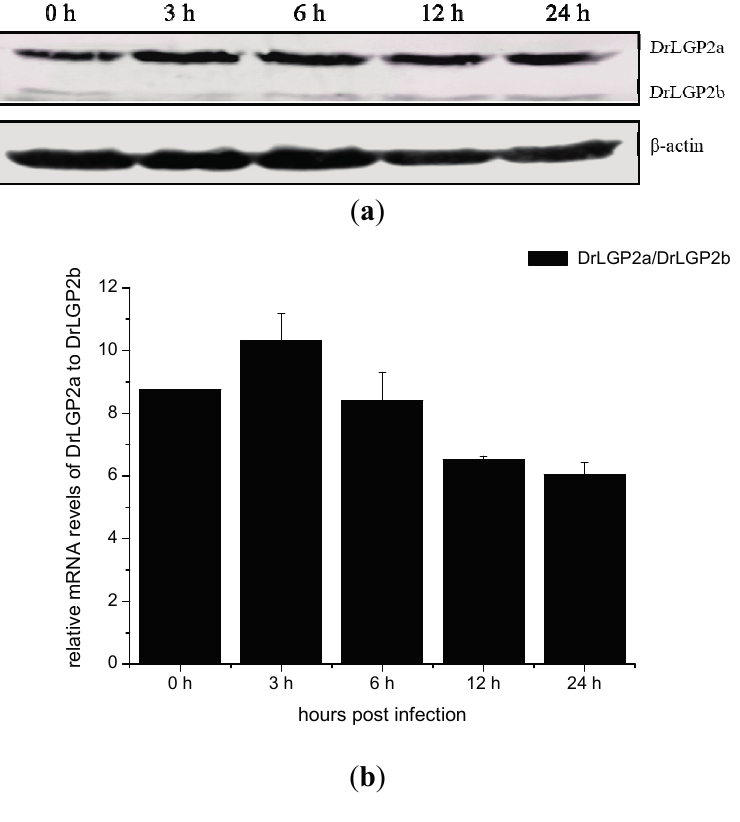
Figure 4. Expression of Retinoic acid-inducible gene I ( RIG-I ), Melanoma differentiation-associated gene 5 ( MDA5 ), LGP2T , and LGP2a genes in ZF4 with time after SHVV infection. Expression was determined by qRT-PCR and β -actin was used as an internal control. Data were shown as mean ± SE ( n = 3). The data were submitted to one-way analysis of variance (one-way ANOVA) followed by Fisher’s LSD test using SPSS. The asterisk indicated a statistically significant difference ( ** p < 0.01, * p < 0.05) compared with 0 h (set as